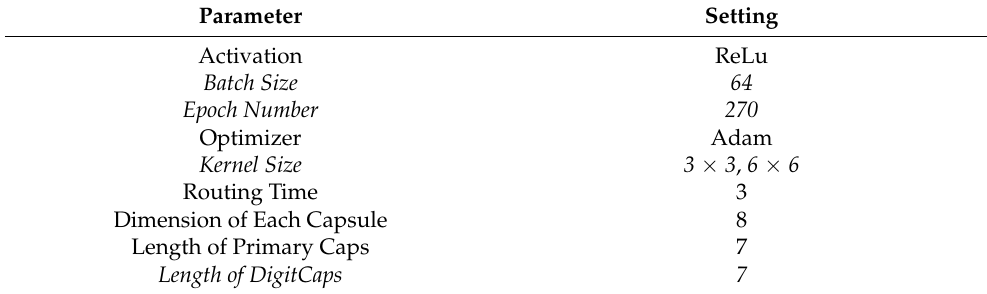
Table 2. Hyperparameter settings (Changed setting: Batch size, kernel size, and length of digitcaps).